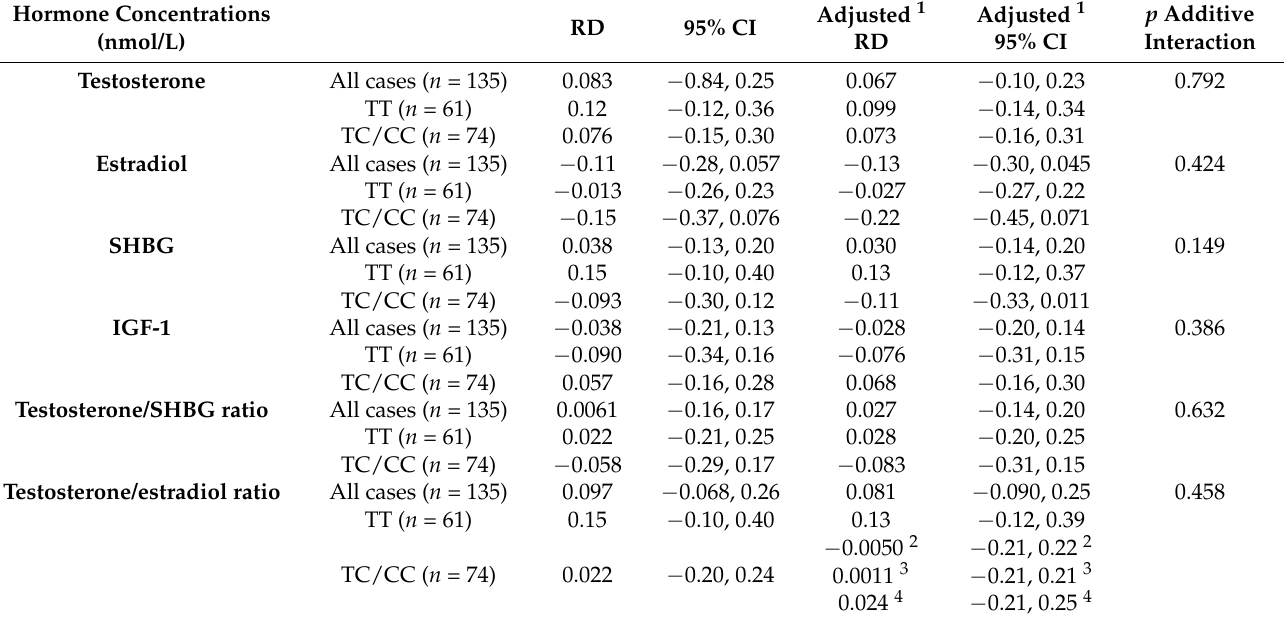
Table 3. Risk differences (RDs) with 95% confidence intervals (CIs) for the risk of increasing different hormone concentrations between baseline and endpoint, in relation to intake of phytoestrogens, stratified by estrogen receptor beta genotype (TT or